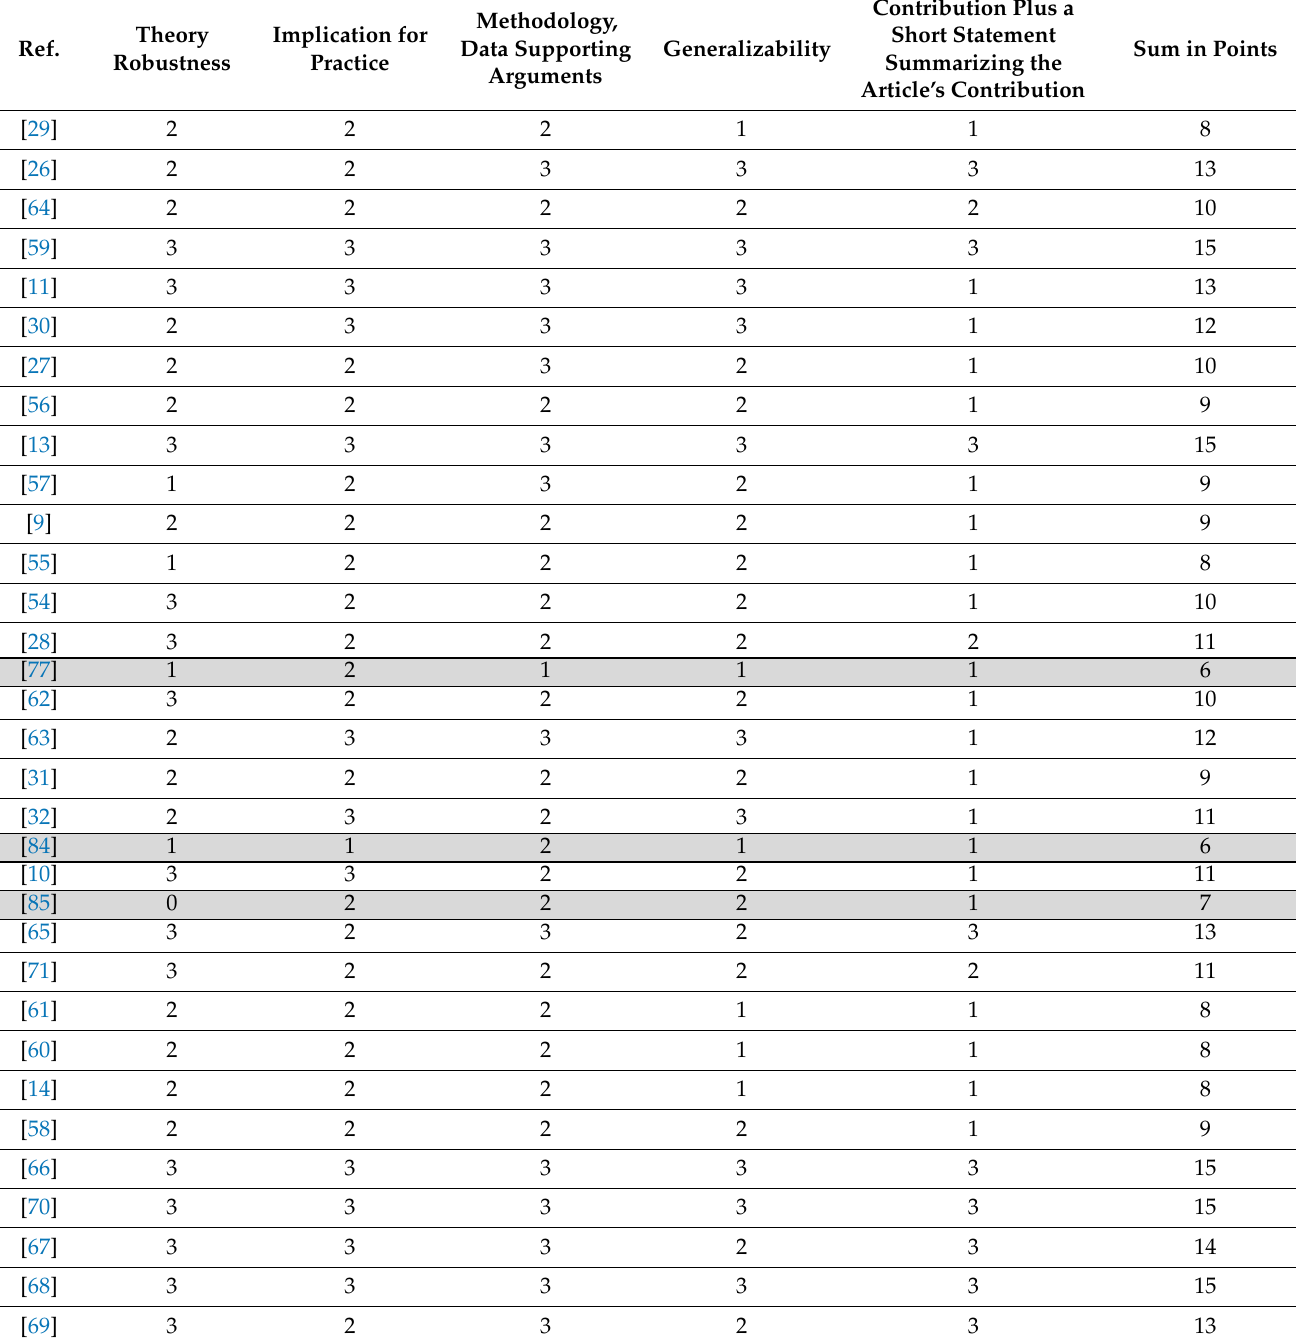
Table 6. The results of the quality assessment in the Included Study .